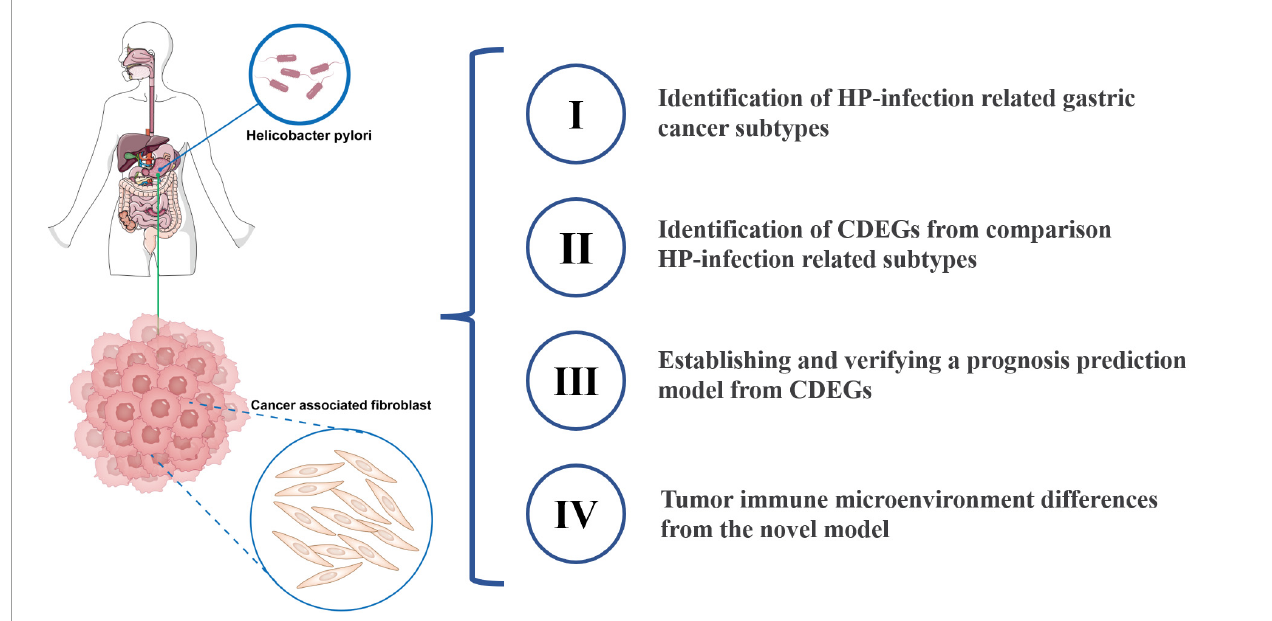
FIGURE1 Diagram of the study. HP, Helicobacter pylori; CDEGs, cancer associated fibroblast related differential expression